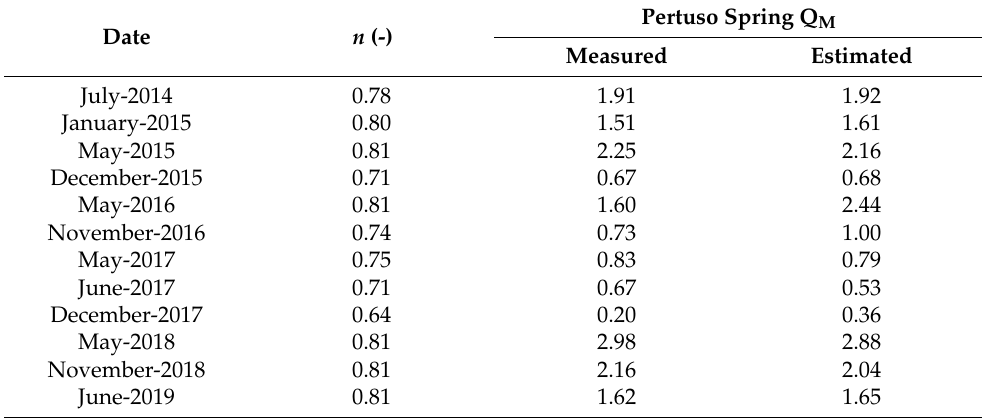
Table 3. Measured and estimated discharges of Pertuso Spring inflows to the Aniene River (Q M ). n (-) Measured